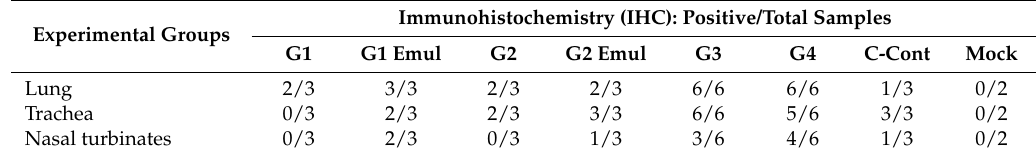
Figure 5. Histological examination of lung pathology with HE stain. Lungs collected at 5dpc were scored for interstitial pneumonia on a scale of 0, no pneumonia, to 4 severe, coalescing to diffuse lymphohistiocytic pneumonia as described in Table 2. The pneumonia score is in the upper right. A representative lung field is shown for ( A ) mock infected control, ( B ) Cont-C, ( C ) G1, ( D ) G1 Emul, ( E ) G2, ( F ) G2 Emul, ( G ) G3 VAERD and ( H ) G4. Bar in A is 100 μm and bar in inset of B is 50 μm. Table 4. Immunohistochemistry and histological score results.